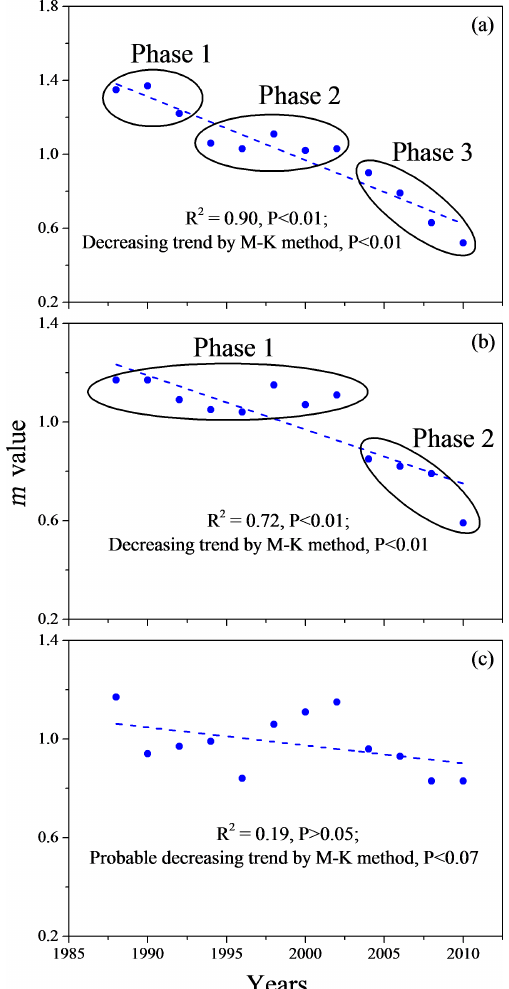
Figure 5. Regional m values at Sites 1, 3, and 4: (a) SO 2 − (b) NO − , and (c) NH + . R 2 reflects the coefficient of determina- 3 4 tion of a variable against the calendar year from LR analysis, and the fitted lines represent the LR function. M–K results are shown in (a–c) . Phases 1, 2, and 3 shown in (a) and Phases 1 and 2 shown in (b) were gained from PLR presented in Sect.